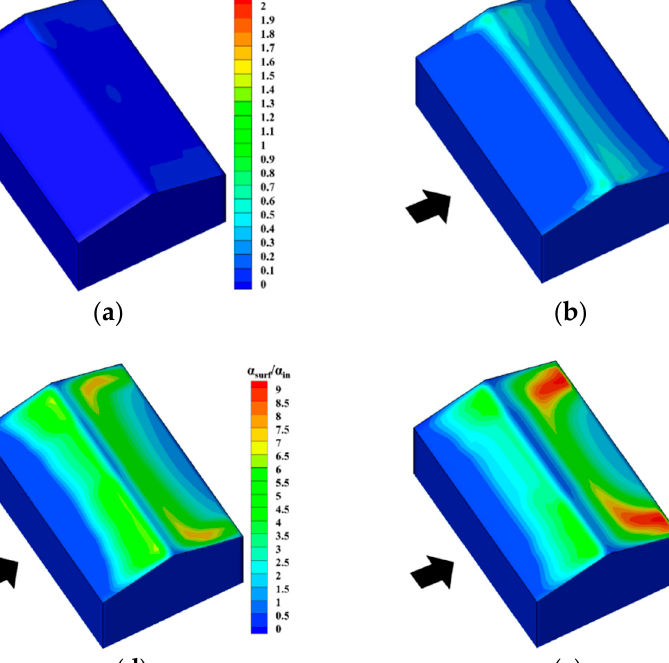
Figure 14. Normalized volume fraction of drifting snow α surf / α in : ( a ) U H = 2 m/s; ( b ) U H = 3 m/s; ( c )